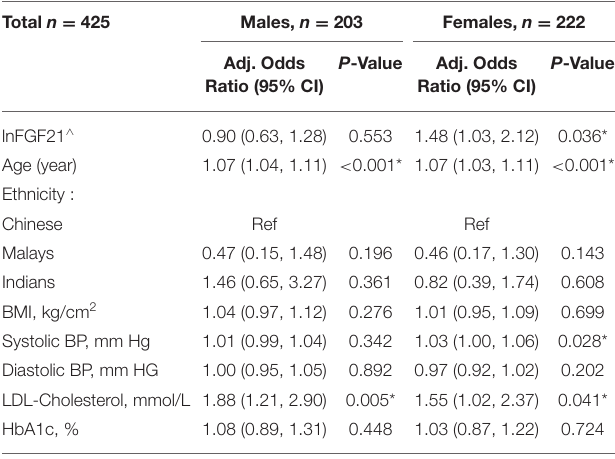
∧ lnFGF21, standardized natural log fibroblast growth factor 21; BMI, body mass index; BP, blood pressure; LDL, low-density lipoprotein; HbA1c, glycated hemoglobin; * p value <